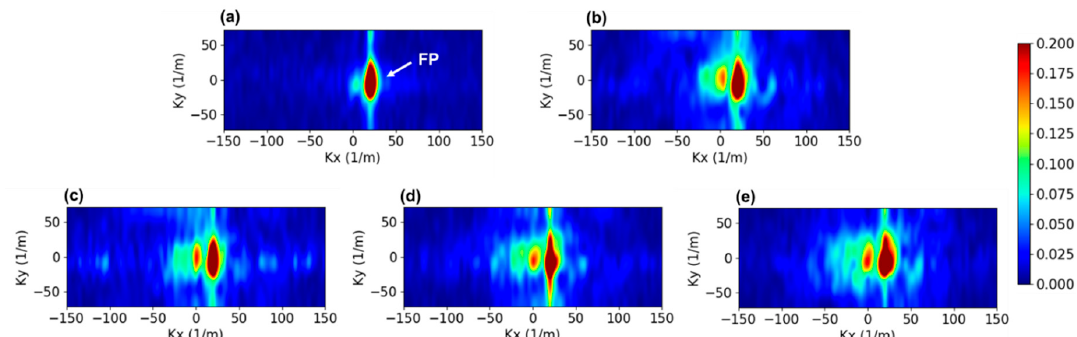
Figure 5. Normalized f-k ( f-k x -k y ) domain magnitude spectra of the wavefield data at the center frequency of excitation ( f = 43 kHz): ( a ) Case 0 (pristine), ( b ) Case 1 (D1 only), ( c ) Case 2 (D1 and D2), ( d ) Case 3 (D1 to D3) and ( e ) Case 4 (D1 to D4). The color bar indicates normalized spectral amplitude.